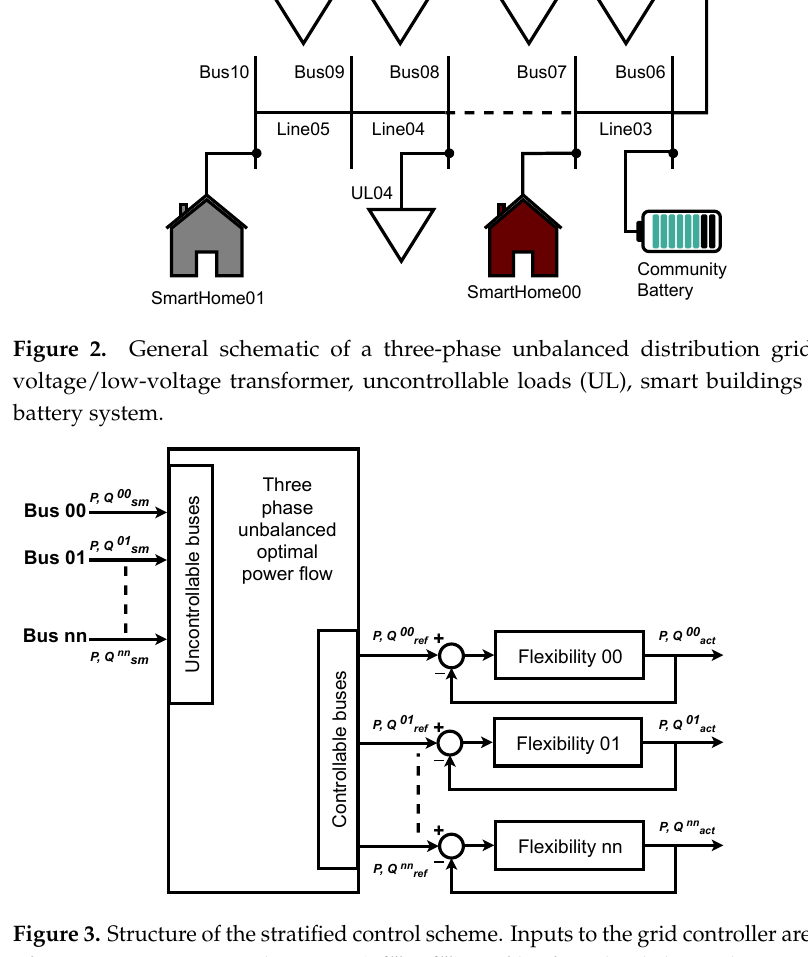
, Q sm ) profiles from loads located at various uncontrollable i i and Q ref set-points that are calculated i i